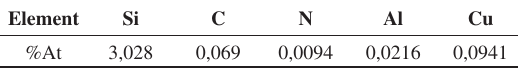
Table 1. Chemical composition of the